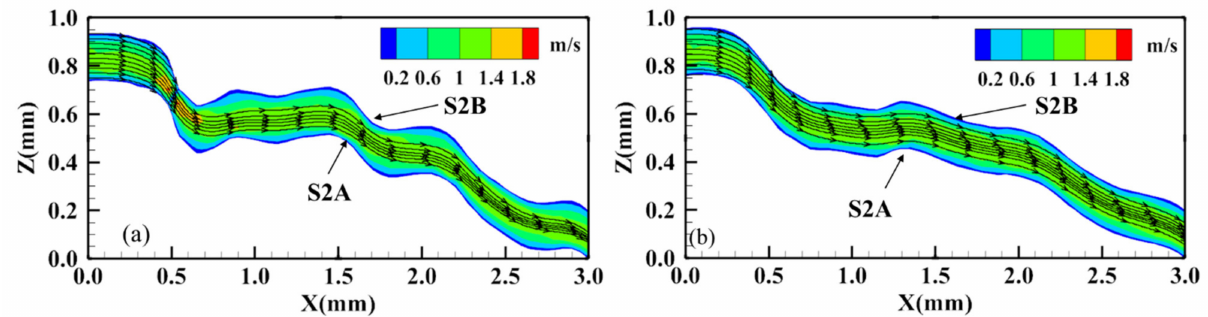
Figure 18. Numerical simulation of fluid flow in idealized fracture model (equal mechanical aperture) by Fluent 16.0. ( a ) fracture before leaching and ( b ) fracture after leaching.